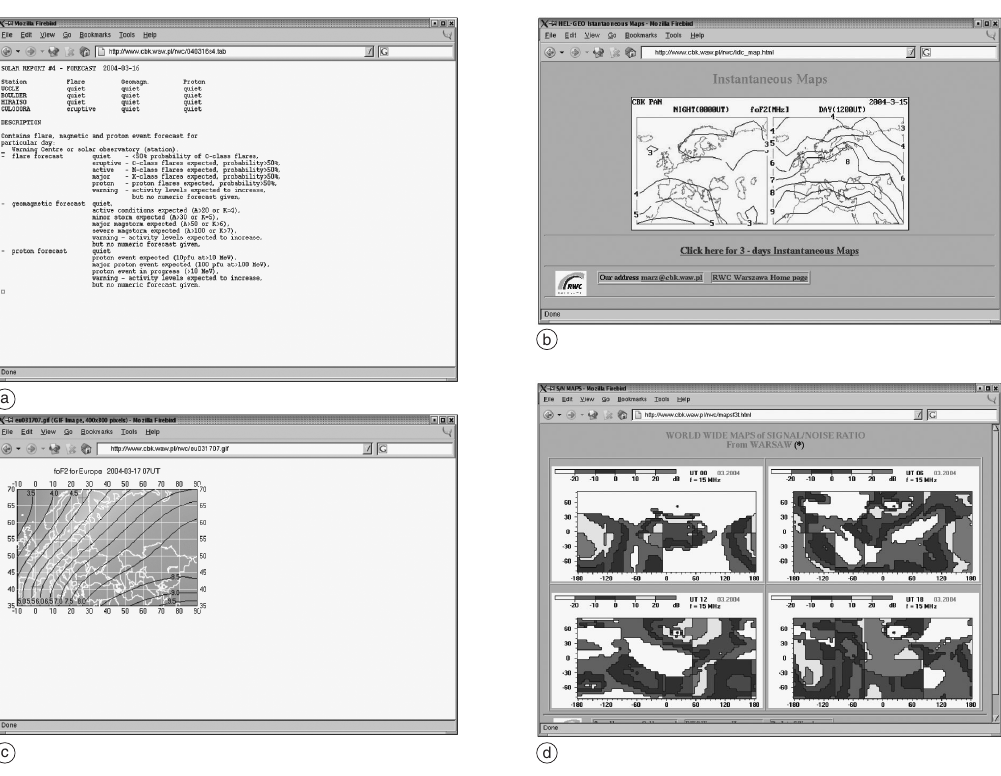
Fig. 3.1a-d. Example data products available from the RWC Warsaw web site. a) A solar forecast for 16.03.2004; b) maps of recent foF 2 for 15.03.2004; c) a forecast map of foF 2 for 17.03.2004; d) predicted glob- al signal-to-noise ratio maps for a 15 kHz signal transmitted from Warsaw in March